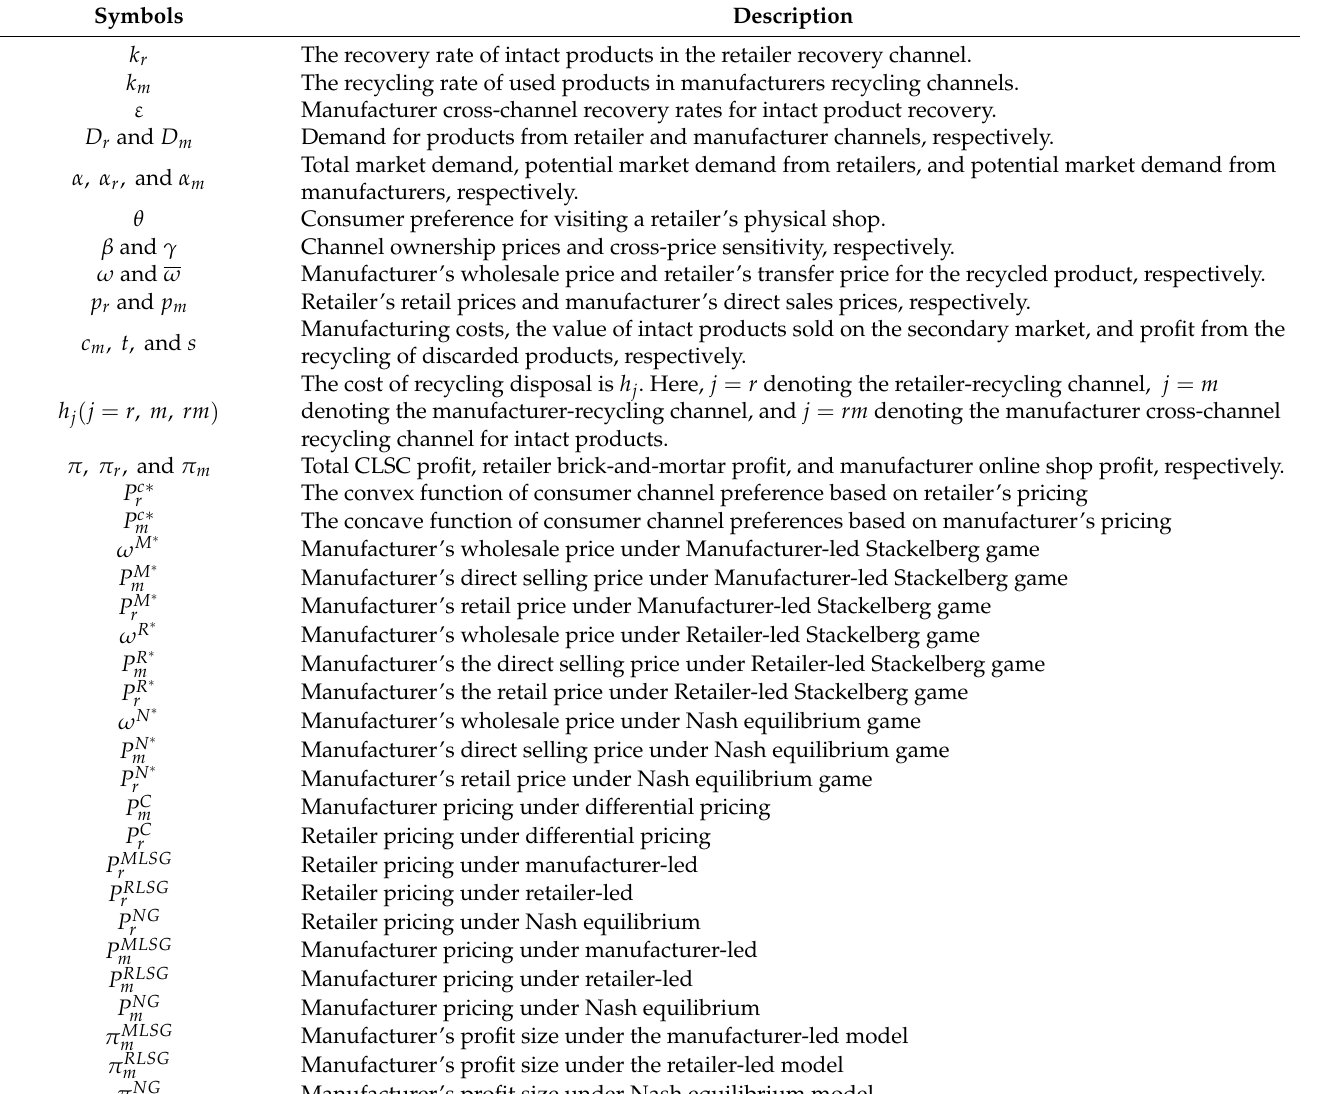
Table 2. Description of